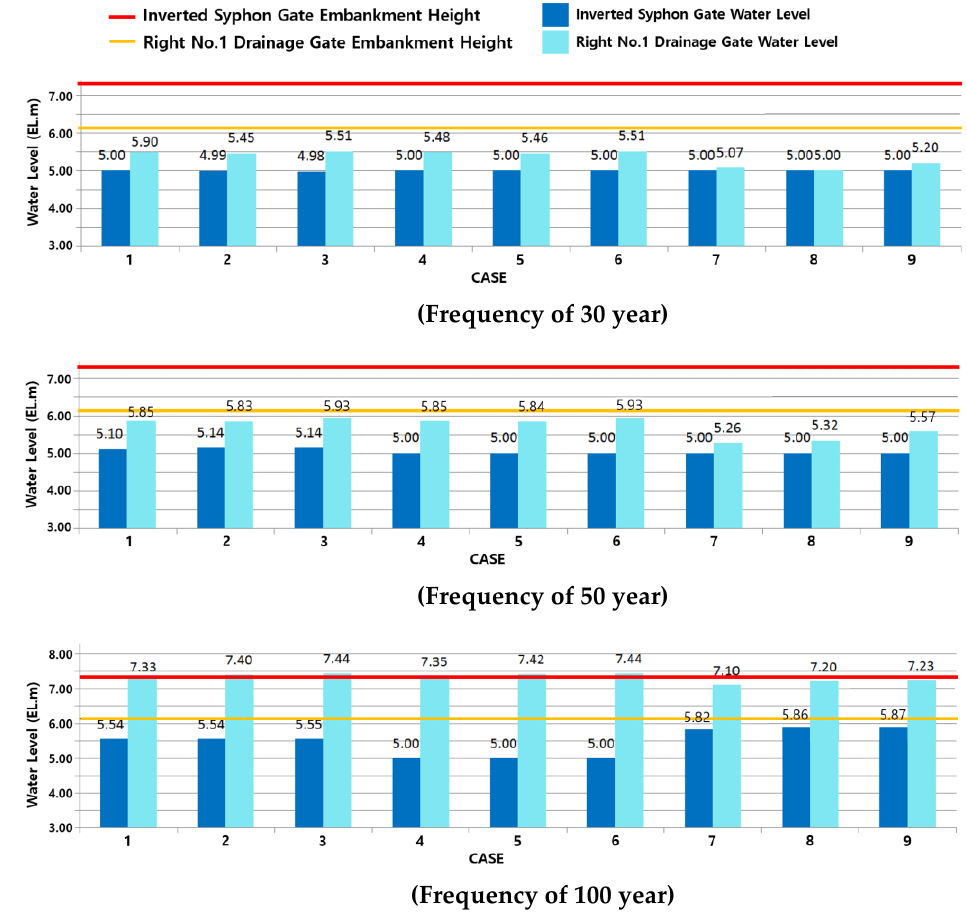
Figure 9. CASE 1-9 and Water Level Results of 30-, 50-, and 100-Year Frequency. Table 6. Summary of Water Level for 30-, 50-, and 100-Year Frequency (EL.m).